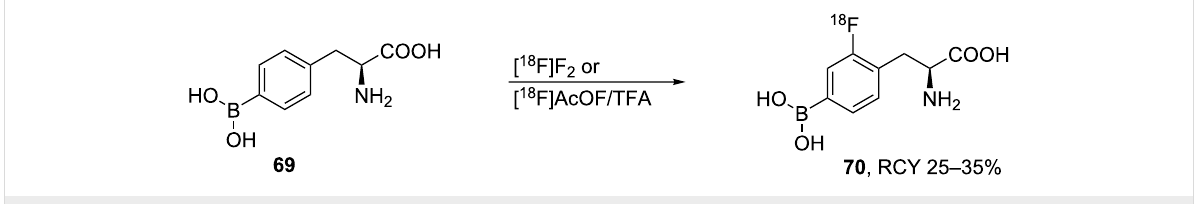
Scheme 16: Synthesis of 4-borono-2-[ 18 F]FPhe.